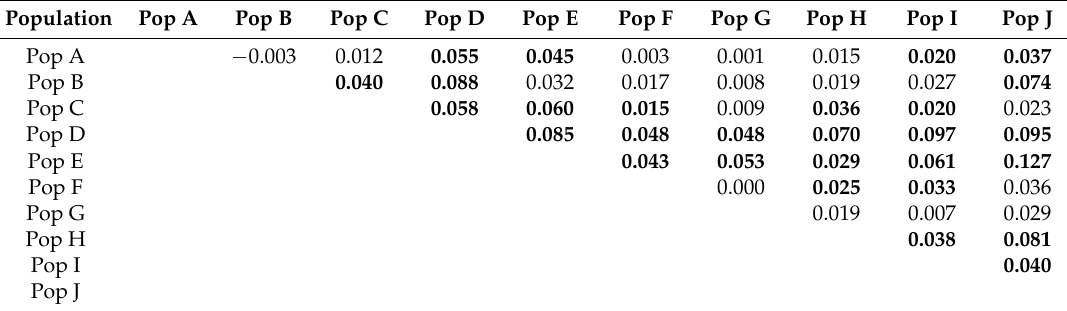
Table 3. Pairwise F ST values between 10 populations of matsutake mushrooms.